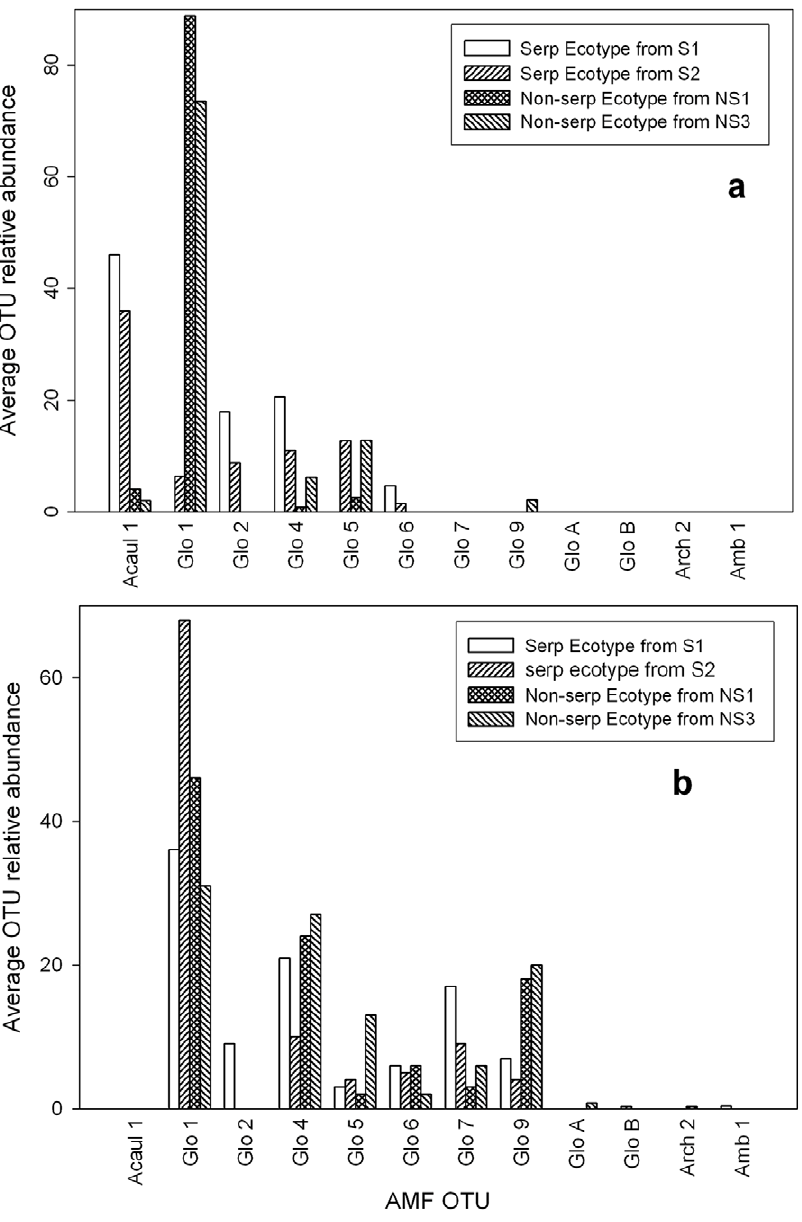
Figure 2. Comparison of the average OTU relative abundance of AMF associated with the Collinsiasparsiflora ecotype populations in the field versus in a common garden. C. sparsiflora ecotypes populations (S1, S2, NS1, and NS3) were grown in a) the field (Schechter and Bruns (2008) or grown in b) a common garden of mixed serpentine and non-serpentine AMF in the greenhouse.